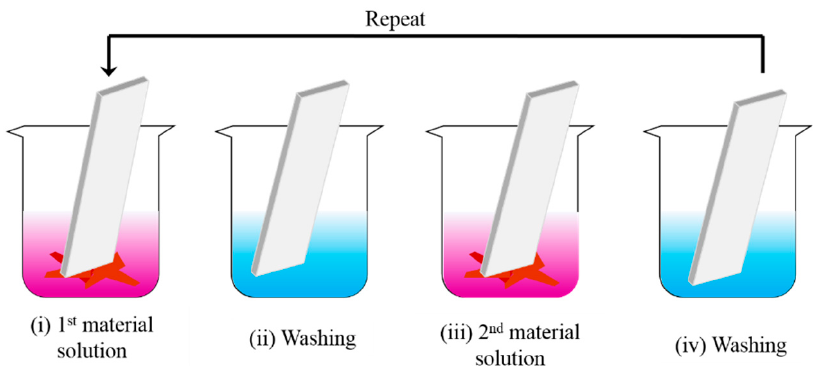
Figure 7. Immersion of charged substrate in a material solution ( i and iii ) with alternate washing ( ii and iv ).